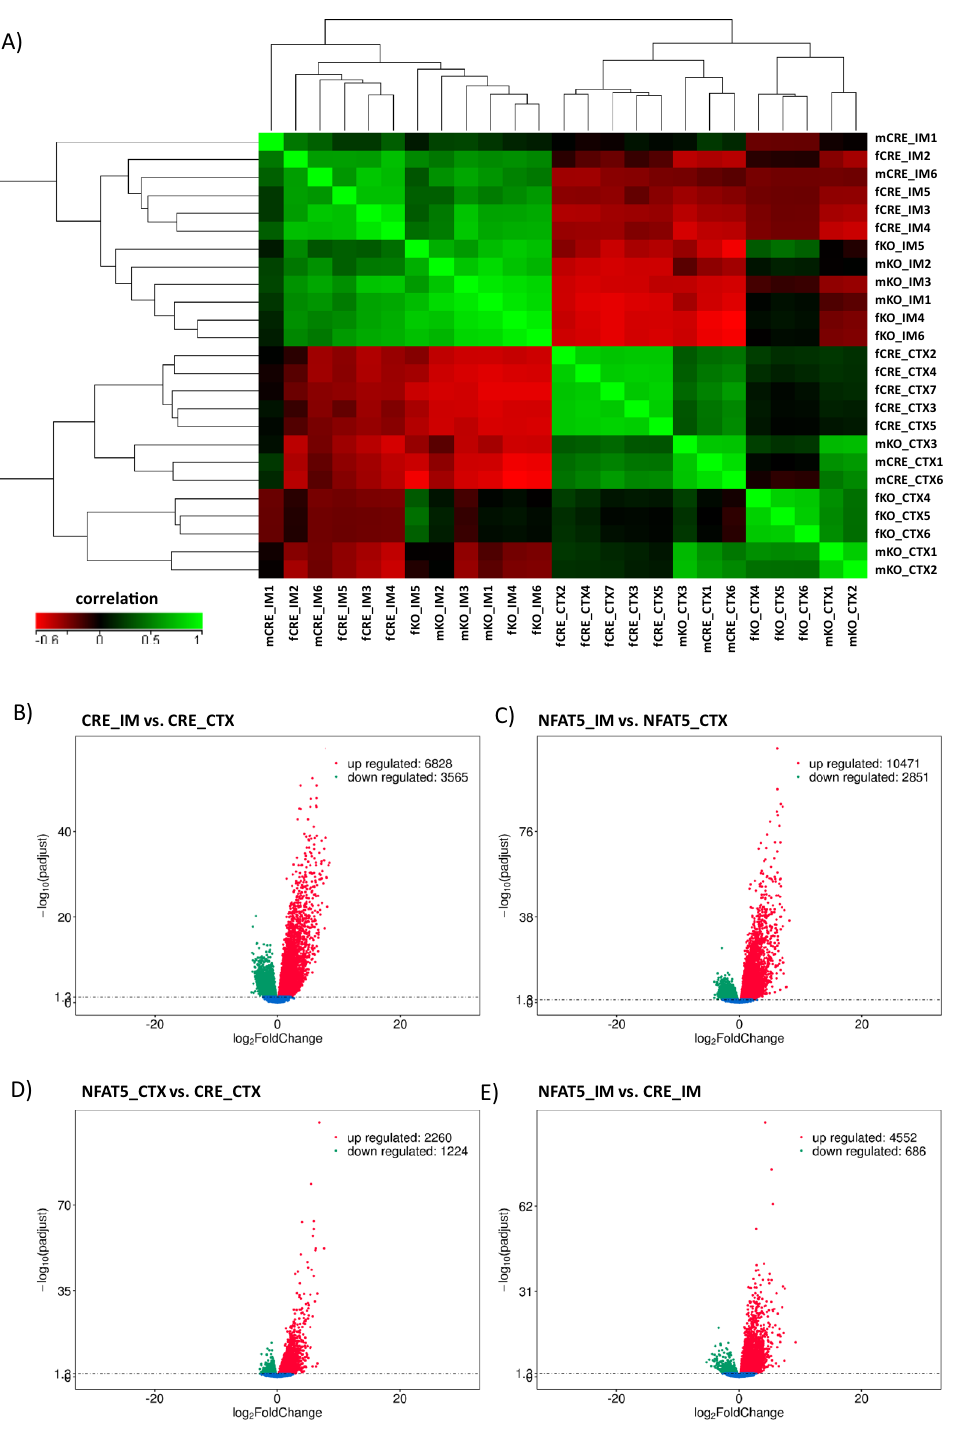
Figure 3. Hierarchical clustering and correlation analysis of transcripts in the renal cortex and inner medulla of control and NFAT5-KO kidneys. ( A ) The global gene expression list from renal cortex (CTX) and inner medulla (IM) of male and female control (CRE) and NFAT5-KO (KO) mice was used for correlation analysis and hierarchical clustering. The color bar indicates the correlation efficiency. The Volcano plots show the number of differentially expressed genes in renal IM ( B ) compared to renal CTX in Aqp2-Cre control mice, ( C ) in IM vs. CTX in PC specific NFAT5-KO mice, ( D ) in CTX of NFAT5-KO mice vs. CTX of control mice and ( E ) in IM of NFAT5-KO mice vs. IM of control